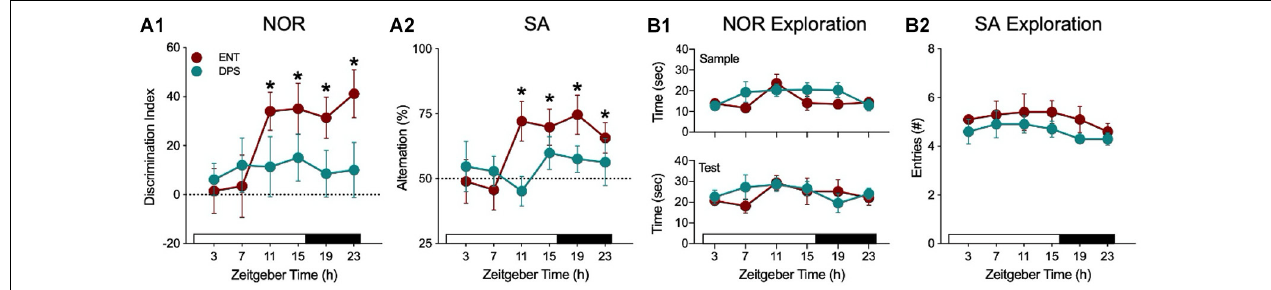
FIGURE 3 | Recognition and spatial working memory were impaired in DPS hamsters. (A) Performance of ENT hamsters (red) and DPS (green) hamsters in the NOR (A1) and SA (A2) tasks at different times of day. * indicates that task performance was significantly different from chance ( P < 0.05; dotted line). In contrast to task performance, exploration behavior, defined as the amount of time spent exploring objects (B1) and number of arm entries (B2) , did not change across the day and did not differ among ENT and DPS hamsters. NOR task used a 60 min interval between sample and test phases. Figure modified from Ruby et al. (2008, 2013).